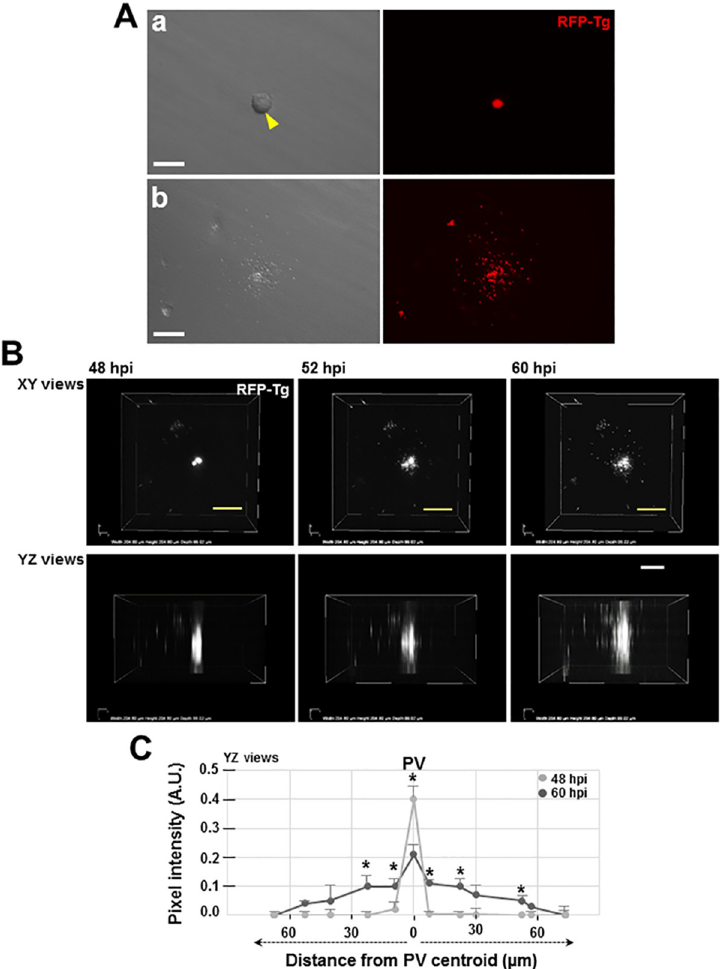
Fig 5. Toxoplasma egress from VERO cells in 3D collagen matrix. A. Microscopy images at 20x of a VERO cell infected with RFP-expressing Toxoplasma (RFP-Tg) for 60 h in a 3D collagen matrix (XY view), showing a representative image of the same PV just before (panel a) or after rupture with parasites escaping in various directions (panel b). Left: phase-contrast images; right: fluorescence microcopy. Arrowhead shows the infected cell from where the parasites escaped. Bar, 40 μ m. B. Live fluorescence microscopy of a VERO cell multi-infected with RFP-expressing Toxoplasma , in a 3D collagen matrix, at the indicated times p.i. Images show top-down (XY) and side-on (YZ) views of the infected VERO cells over the course of parasite egress. After 52 h of infection, individual parasites escape the ruptured cell in all directions and at 60 h p.i. a more diffuse fluorescence signal appears concomitant with parasite dispersion in the matrix as they move away from the former host cell. Scale bars, 50 μ m. C. Quantification of fluorescence intensity of RFP-expressing Toxoplasma within the PV (48 h p.i.) or during egress (60 h p.i.). Regions-of- Interest corresponding to the fluorescence signal of parasites were drawn at the indicated distances from the ruptured cell to collect numbers that are integrated pixel intensity of entire area minus background using the ImageJ analysis program. Data are means of three independent biological experiments (n = 4 to 9 PV) showing statistical differences between distances from the PV centroid at 48 and 60 hpi ( � , p < 0.05 with two-tailed